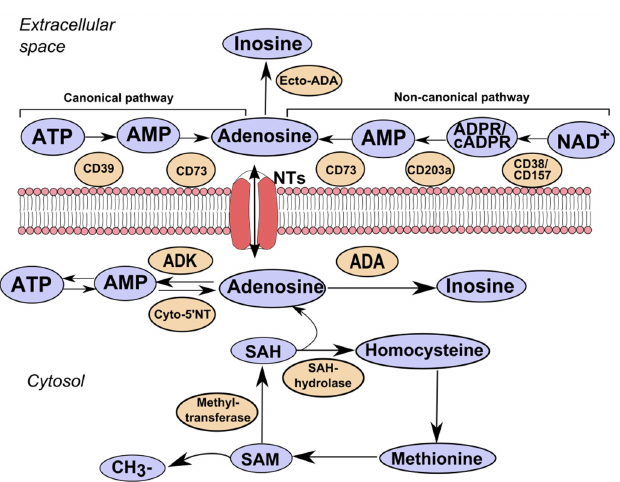
Figure 1. Adenosine metabolism. The canonical pathway of adenosine synthesis involves the hydrolysis of ATP to AMP by ecto-nucleoside triphosphate diphosphohydrolase (NTPDase1, CD39) and the hydrolysis of AMP by ecto-5 ′ -nucleotidase (5 ′ NT, CD73). The non-canonical pathway in- volves the use of NAD + as a substrate by CD38 or CD157 to generate ADP-ribose (ADPR) directly or through its cyclic form (cADPR). ADPR is then processed to AMP by CD203a (Ectonucleotide Pyrophosphatase/Phosphodiesterase 1). Extracellular adenosine can bind to its receptors or be me- tabolized to inosine by ecto-adenosine deaminase (ecto-ADA). Adenosine is transported into and out of the cell by concentrative or equilibrative nucleoside transporters (NTs). Intracellular adeno- sine synthesis is controlled by the balance of the activity of enzymes: adenosine kinase (ADK), cy- toplasmic 5 ′ nucleotidase (Cyto-5 ′ NT), adenosine deaminase (ADA). Adenosine is generated as an end product in the transmethylation reaction: transmethylation reactions include the transfer of me- thyl groups from S-adenosylmethionine (SAM) to a wide range of acceptors. The resulting product, S-adenosylhomocysteine (SAH), is then cleaved by SAH hydrolase (SAHH) into adenosine and ho- mocysteine.